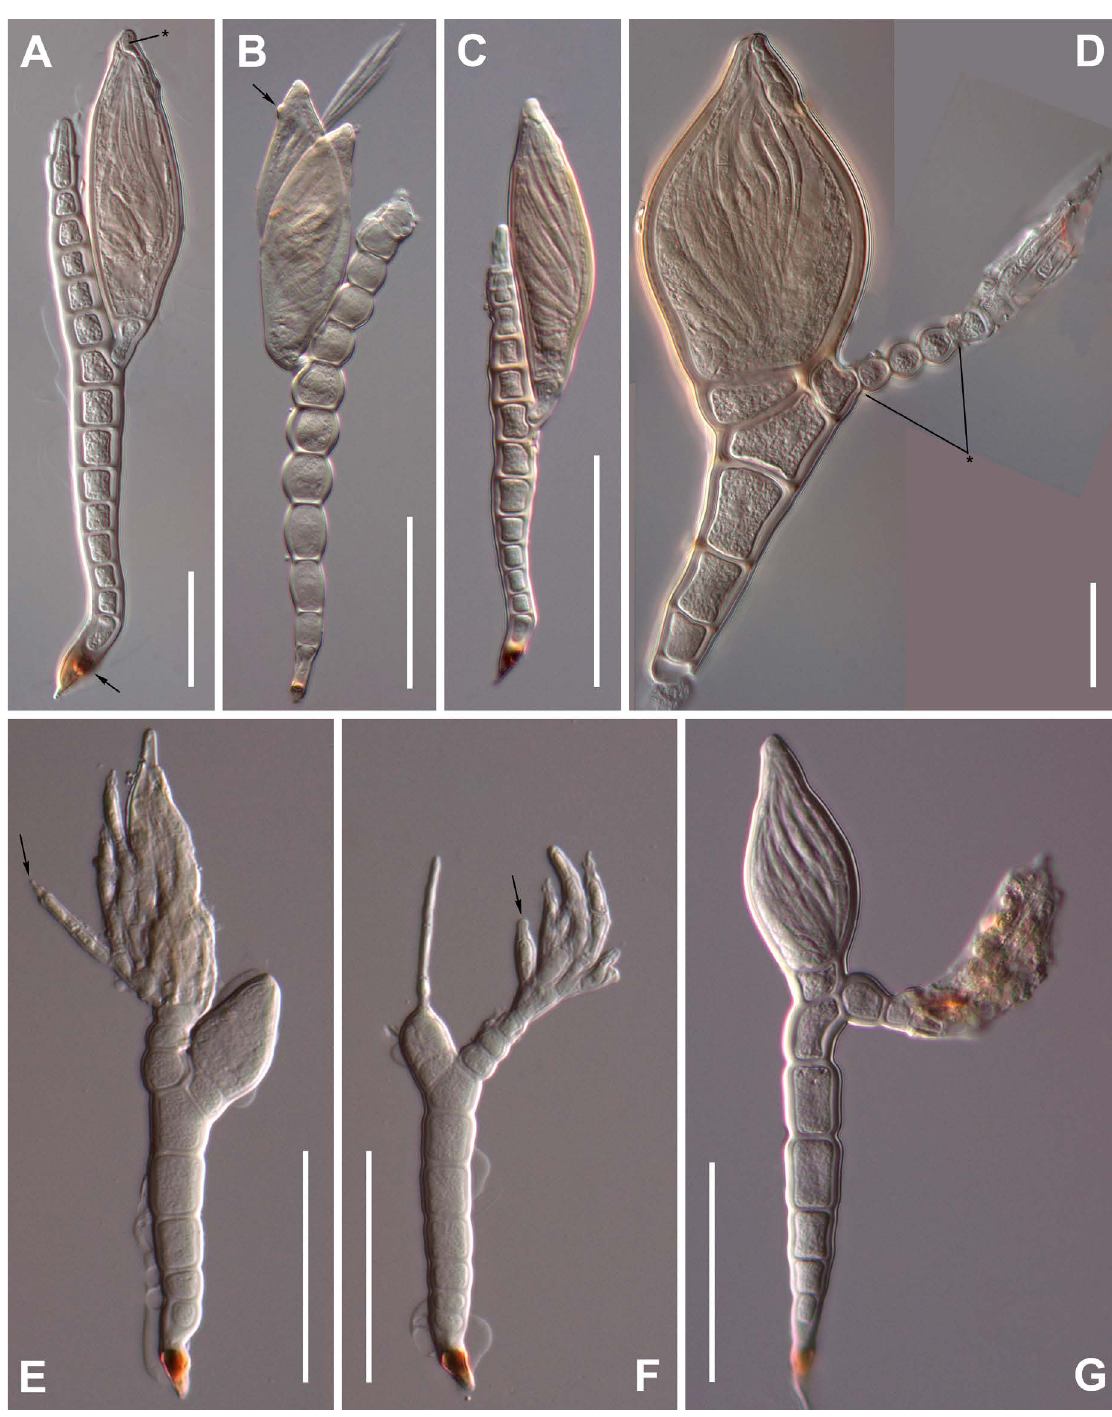
Fig. 13. Siemaszkoa spp. A – C . S. ptenidii (Scheloske) I.I.Tav. & T.Majewski. Mature thalli showing protruding lip in A (*), and a trichogyne stump in B (arrow). Thallus in B has developed two mature perithecia. – D – G . S. ramificans T.Majewski. D . Mature thallus showing cells of the base of the appendage typically inflated (*). E – F . Immature thalli showing antheridia (arrows). G . Mature thallus. Scale bars: A, D = 20 µm; B–C, E–G = 50 µm. Photographs from slides ZMUC C-F-123285 (A), ZMUC C-F-123972 (B), ZMUC C-F-123227 (C), ZMUC C-F-122719 (D), ZMUC C-F-122797 (E–F), ZMUC C-F-124322